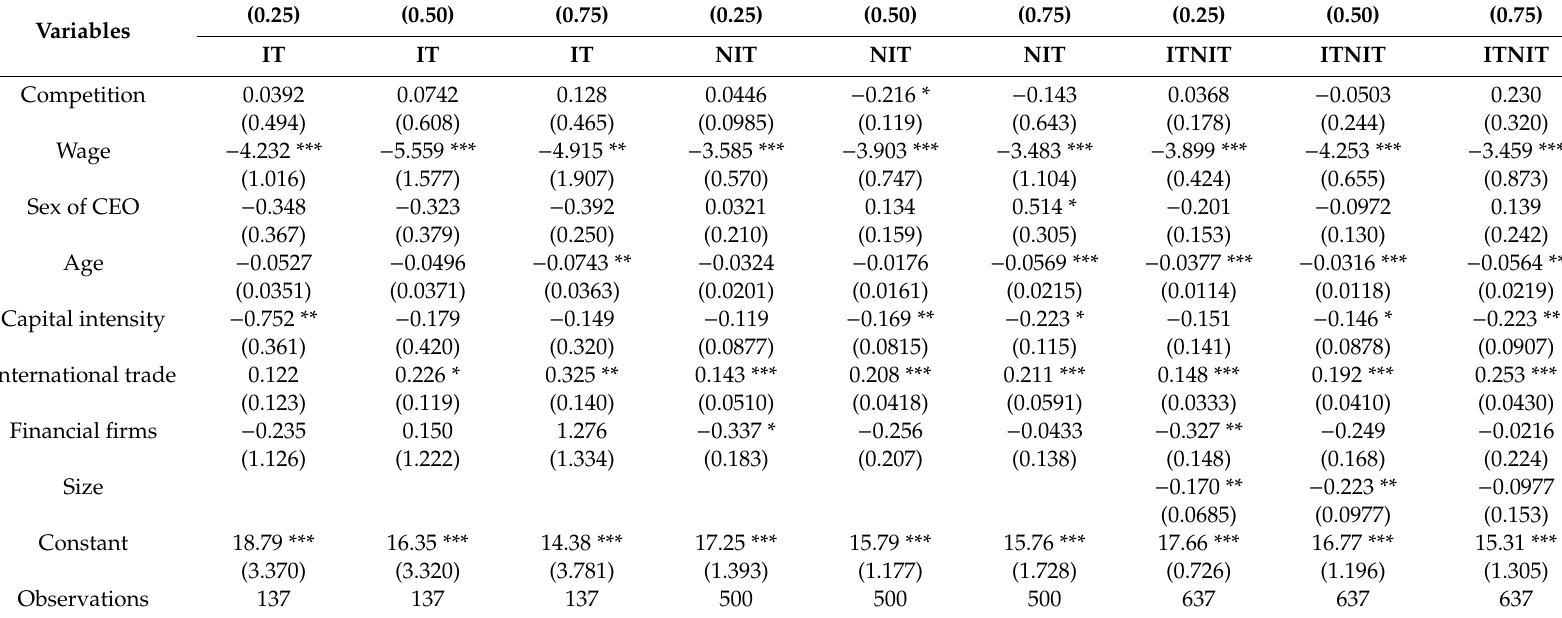
Table 8. Quantile regression results for noninternational trading